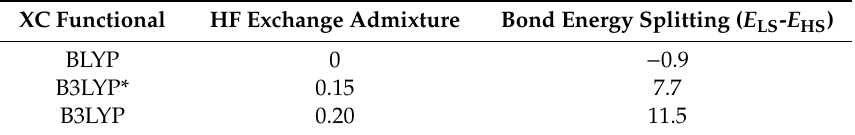
Table 1. High-spin / Low-spin bond energy splitting (kcal mol − 1 ) in 5B complex as derived from single-point calculations at selected exchange-correlation (XC) functionals. A positive value in energy splitting indicates that the predicted ground state is high-spin.